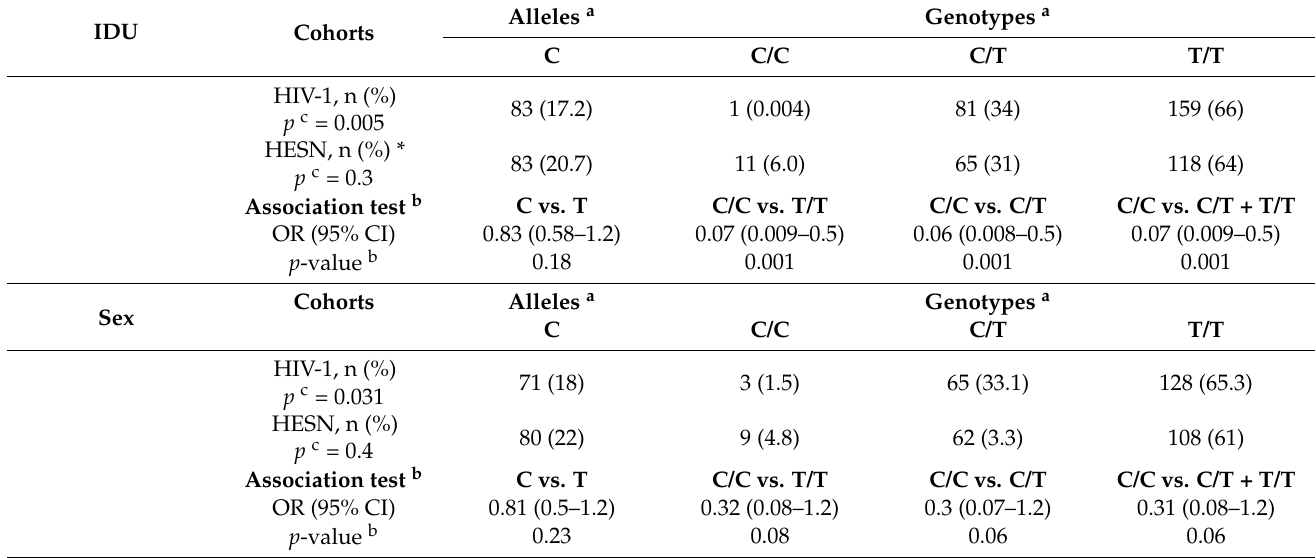
Table 1. Allelic and genotypic distribution in HIV-1 infected and HESN subjects.